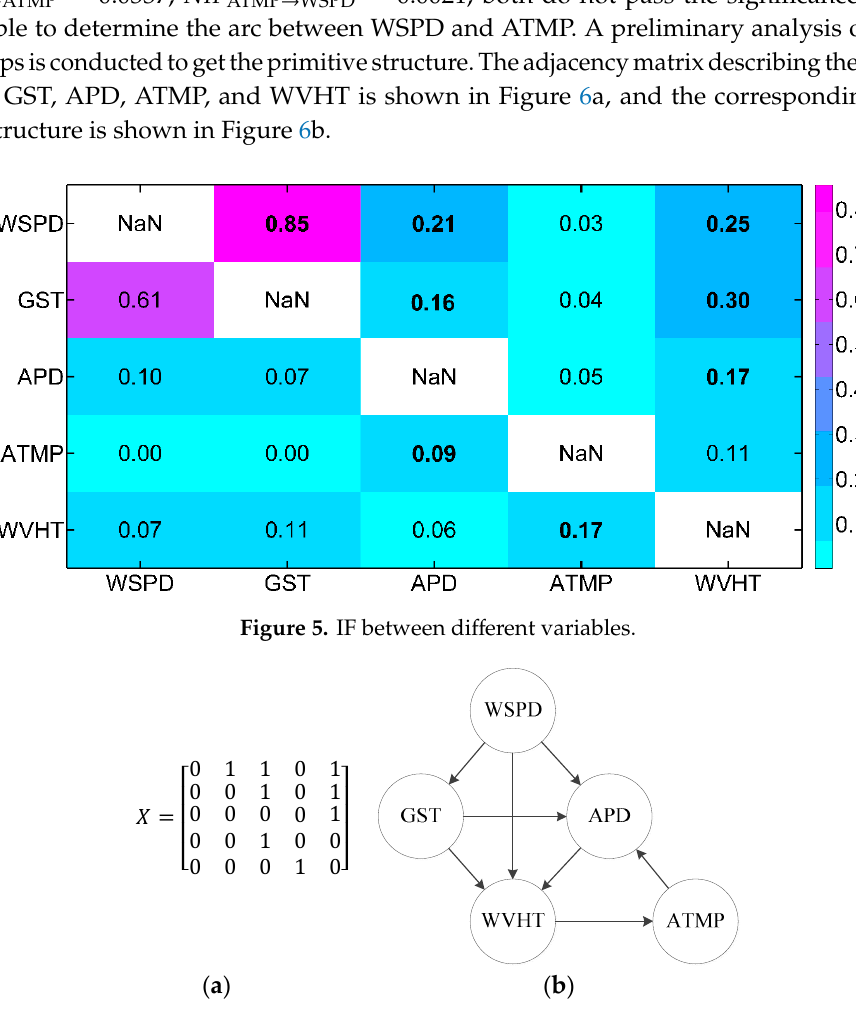
Figure 6. Results of causal analysis; ( a ) adjacency matrix, ( b ) primitive structure.